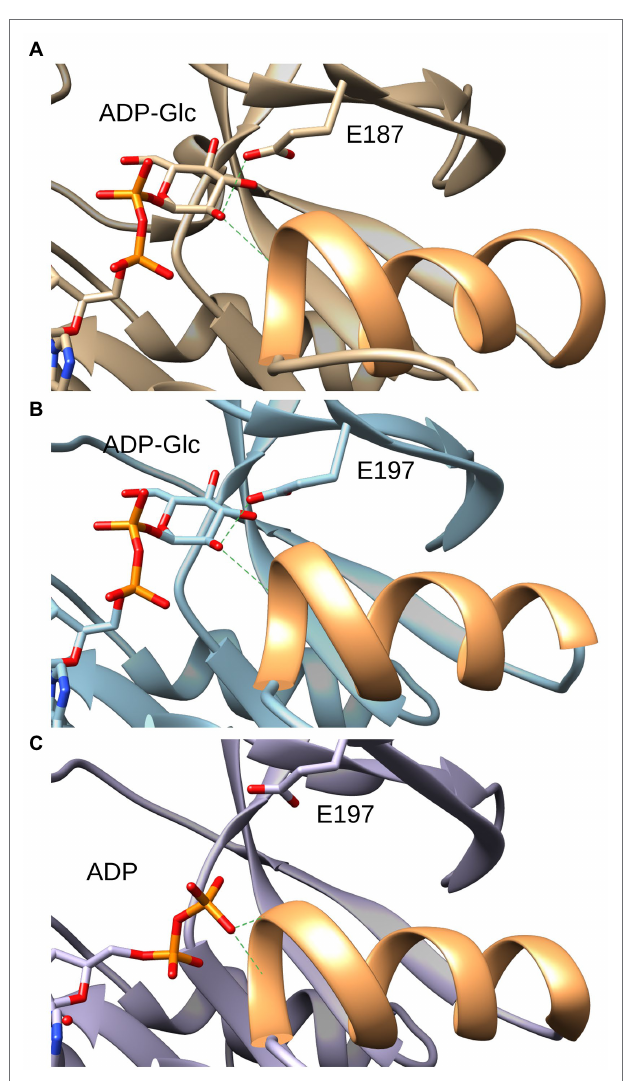
FIGURE 3 | Interaction of the glucose moiety of the product ADP-Glc with the ADP-Glc PPase from Agrobacterium tumefaciens and potato tuber. (A) Structure of the A. tumefaciens ADP-Glc PPase in which ADP-Glc has been modeled as described in the section “Materials and Methods.” In orange is the ribbon corresponding to the α -helix from residues F233 to H244. Green dashes indicate the distance from the OH (position 2) to the side chain oxygen of the E187 residue (3.1 Å) and to the backbone N of the residue G234 (4.0 Å), respectively. (B) : Structure of the small subunit ADP-Glc PPase from potato tuber (PDB ID: 1YP4, subunit B) with ADP-Glc in the active site. In orange is the ribbon corresponding to the α -helix from residues F254 to S264. Green dashes indicate the distance to the O of side chain of the E197 residue (2.8 Å) and to the N of the backbone of the residue G255 (4.0 Å), respectively. (C) Structure of the small subunit ADP-Glc PPase from potato tuber (PDB ID: 1YP4, subunit A) with ADP in the active site. In orange is the ribbon corresponding to the α -helix from residues F254 to S264. Green dashes indicate the distance from the closest O of the β -phosphate of ADP to the backbone nitrogen of the S256 residue (3.3 Å) and to the backbone nitrogen of the residue G255 (3.9 Å),